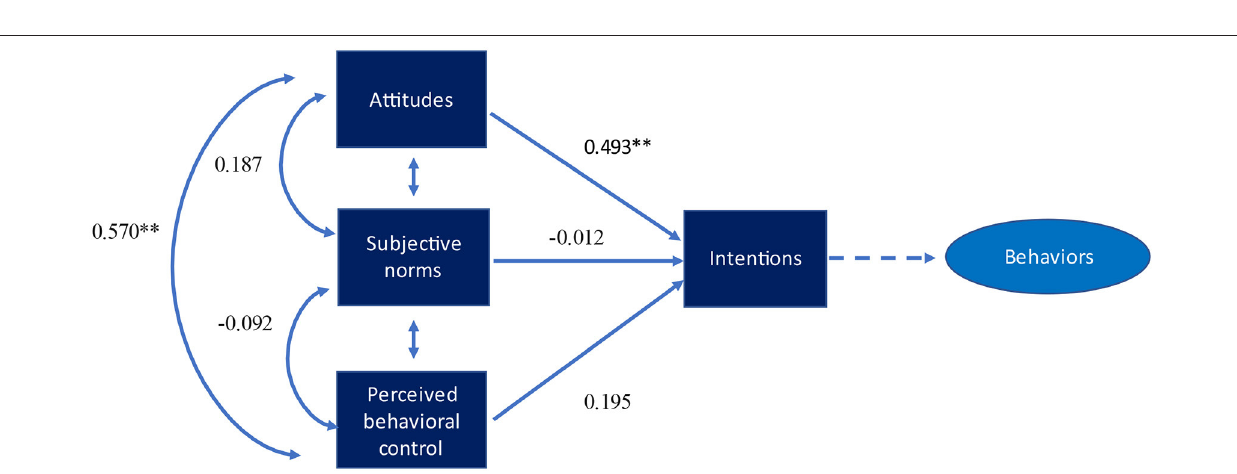
FIGURE 2 | Path model with standardized regression coefficients for being responsible in digital world. * p < 0.05; ** p < 0.01.